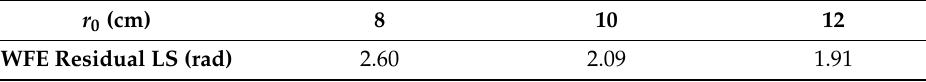
Table 3. Average of the residual wavefront error obtained by the least squares (LS) method in simula- tions of a Solar SCAO AO system with a telescope of 1.5 m of diameter and 15 × 15 subapertures over 400 samples for 3 different tests. Each test has a fixed r 0 value and one turbulence layer varying from 0 to 16 km. The data are extracted from [33].